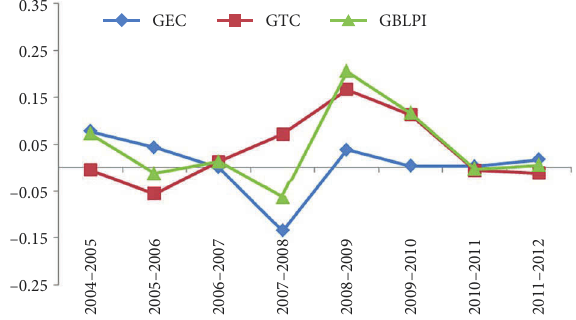
Figure 1. Trends in GBLPI, GEC and GTC of the SOCB